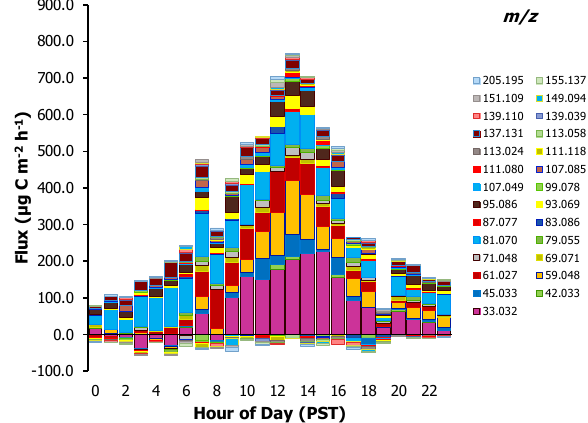
Fig. 10. (a) Total monoterpenes vertical gradient from PTR-MS as a sum of m/z 81 and 137, and (b) flux of 887 individual m/z of 81.070 (in blue circle), 95.086 (in black triangle) and 137.131 (in red square) from PTR-TOF-MS 888 with standard errors (error bars). Gradient pattern and flux both show emission throughout the day and m/z 81.070 889 (main fragment of monoterpenes) shows the largest flux among the 3 ions. 890 891